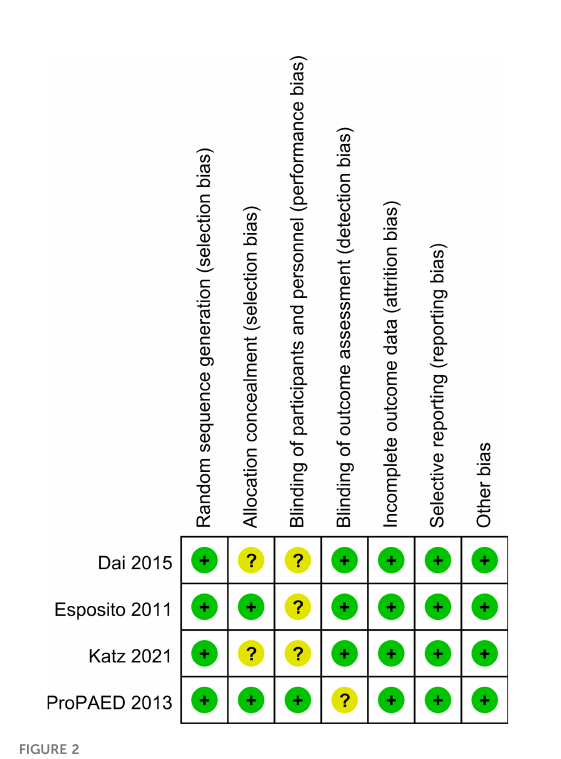
FIGURE 2 Quality evaluation with Cochrane ’ s risk of bias